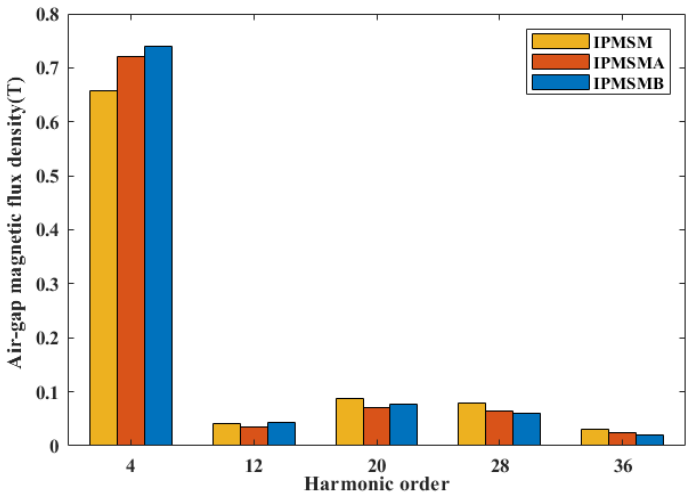
Figure 10. Fourier Decomposition of No-Carrier Gas Magnetic Density for Three Structure Motors.